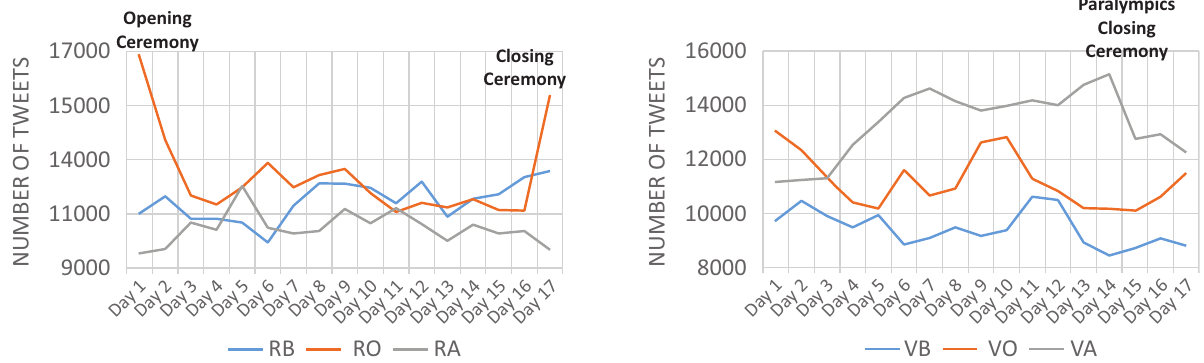
Figure 5. Daily tweets density for residents and visitors for the three temporal bins (R = residents, V = visitors; B = before OG, O = during OG, A = after OG).